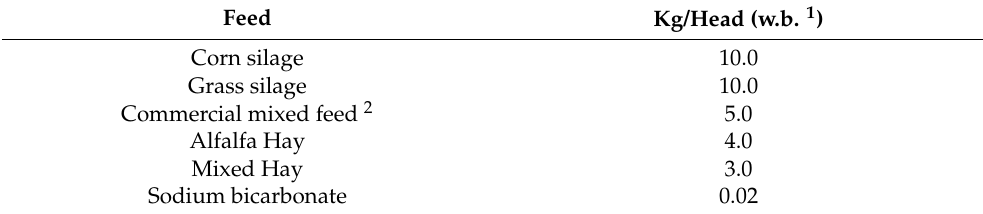
Table 2. Composition of the standard